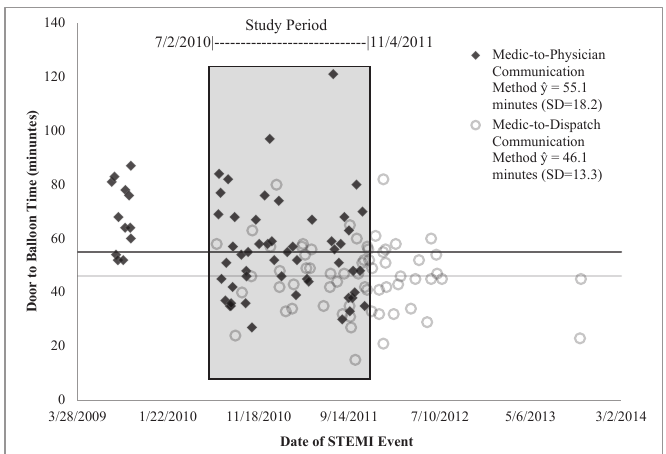
Figure 3. Door-to-balloon time over the length of the study. The shaded area reflects observations included in the analysis.